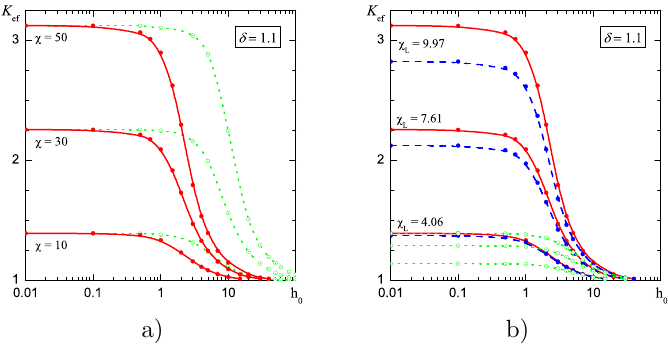
Figure 3. Dependence of the shielding effectiveness factor K ef on the dimensionless applied magnetic-field intensity h 0 for the dimensionless layer thickness δ = 1 . 1. The ferrofluid properties are defined two ways: by the initial magnetic susceptibility χ = { 10 , 30 , 50 } (a) and by the Langevin permeability χ L = { 4 . 06 , 7 . 61 , 9 . 97 } (b). Dotted lines correspond to model 1, dashed lines to model 2, solid lines to model 3. On the scale of the graph, the results for model 2 are indistinguishable from those of model 3 in (a). Lines for model 1 in (b) correspond to increasing values of χ L